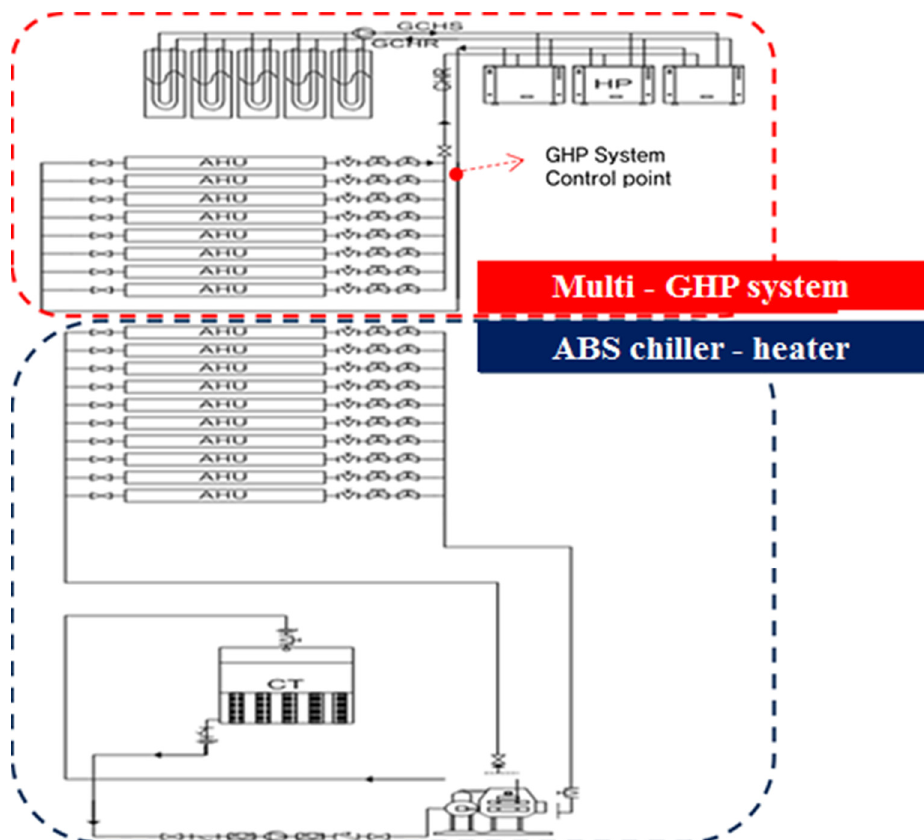
Figure 2. Schematic diagram of the operation of the target building.